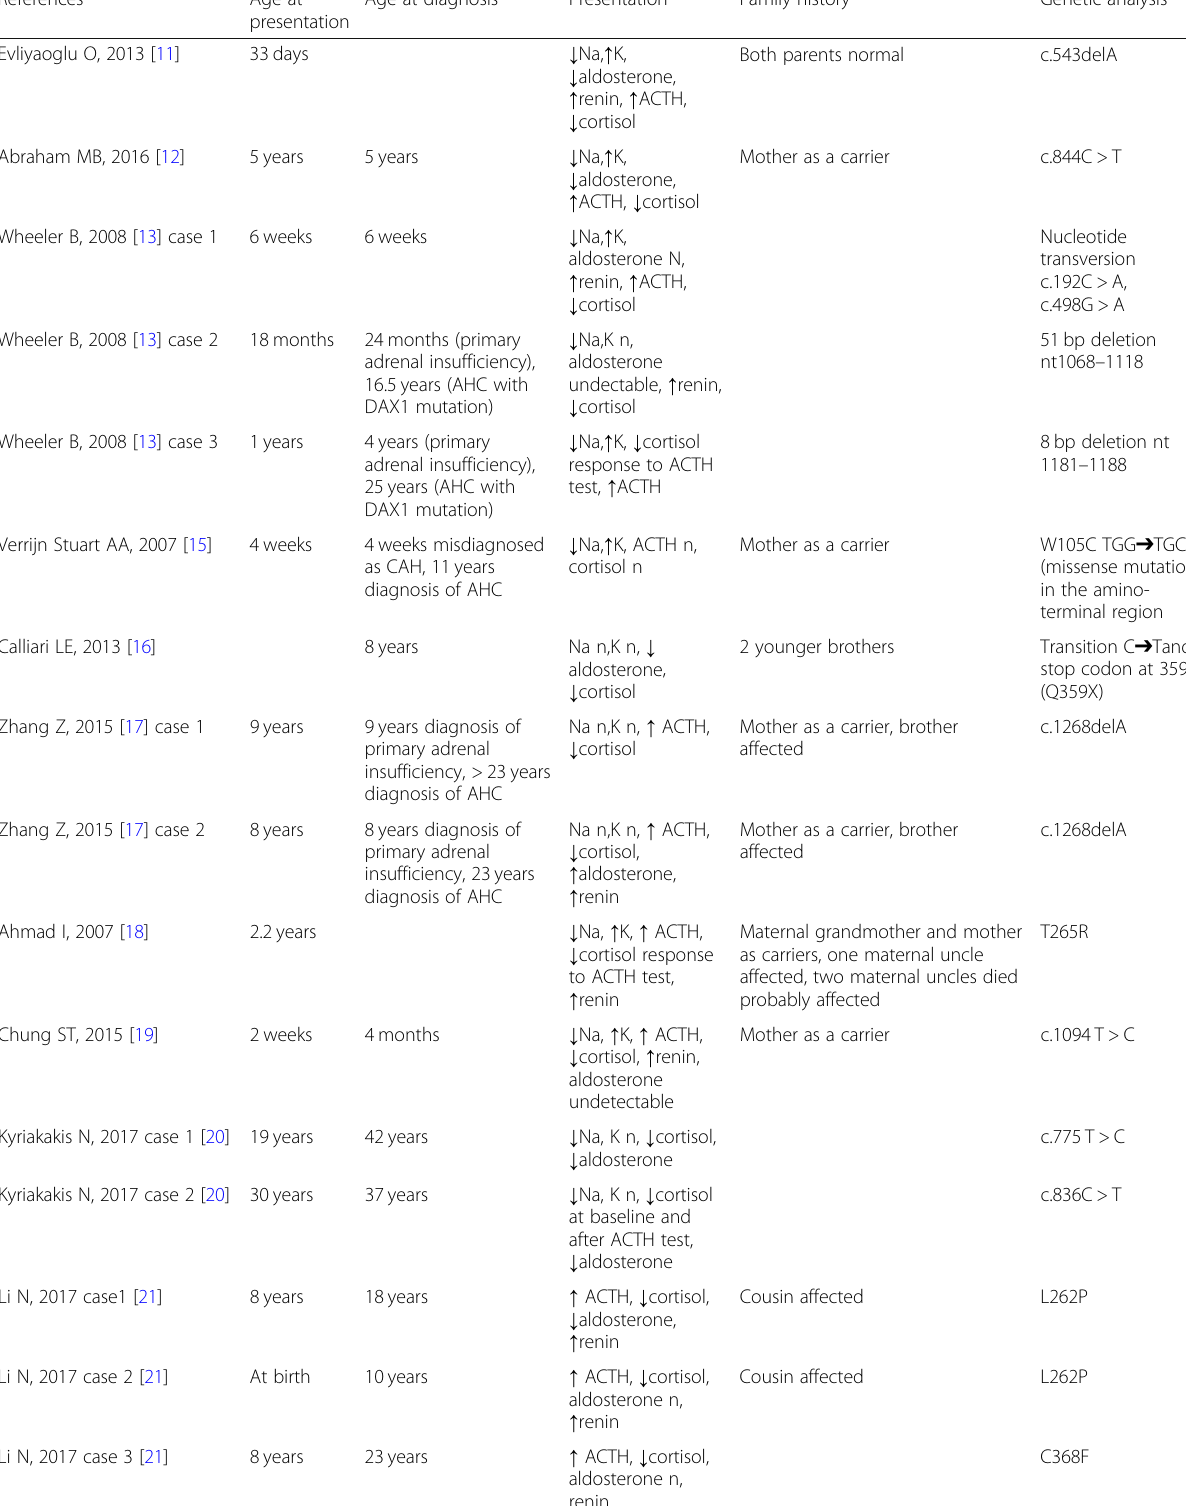
Table 2 Recent cases of ACH described in literature: main clinical and genetic